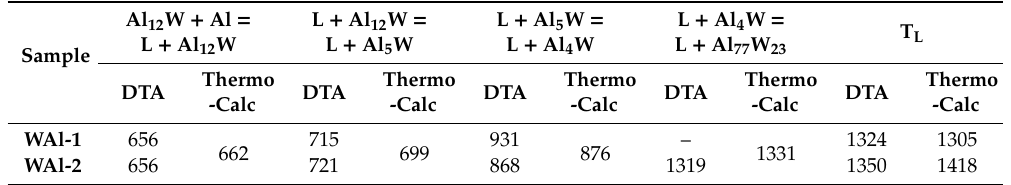
Table 4. Measured values of phase transformations in W–Al-VIM-1 and W–Al-VIM-2 samples by